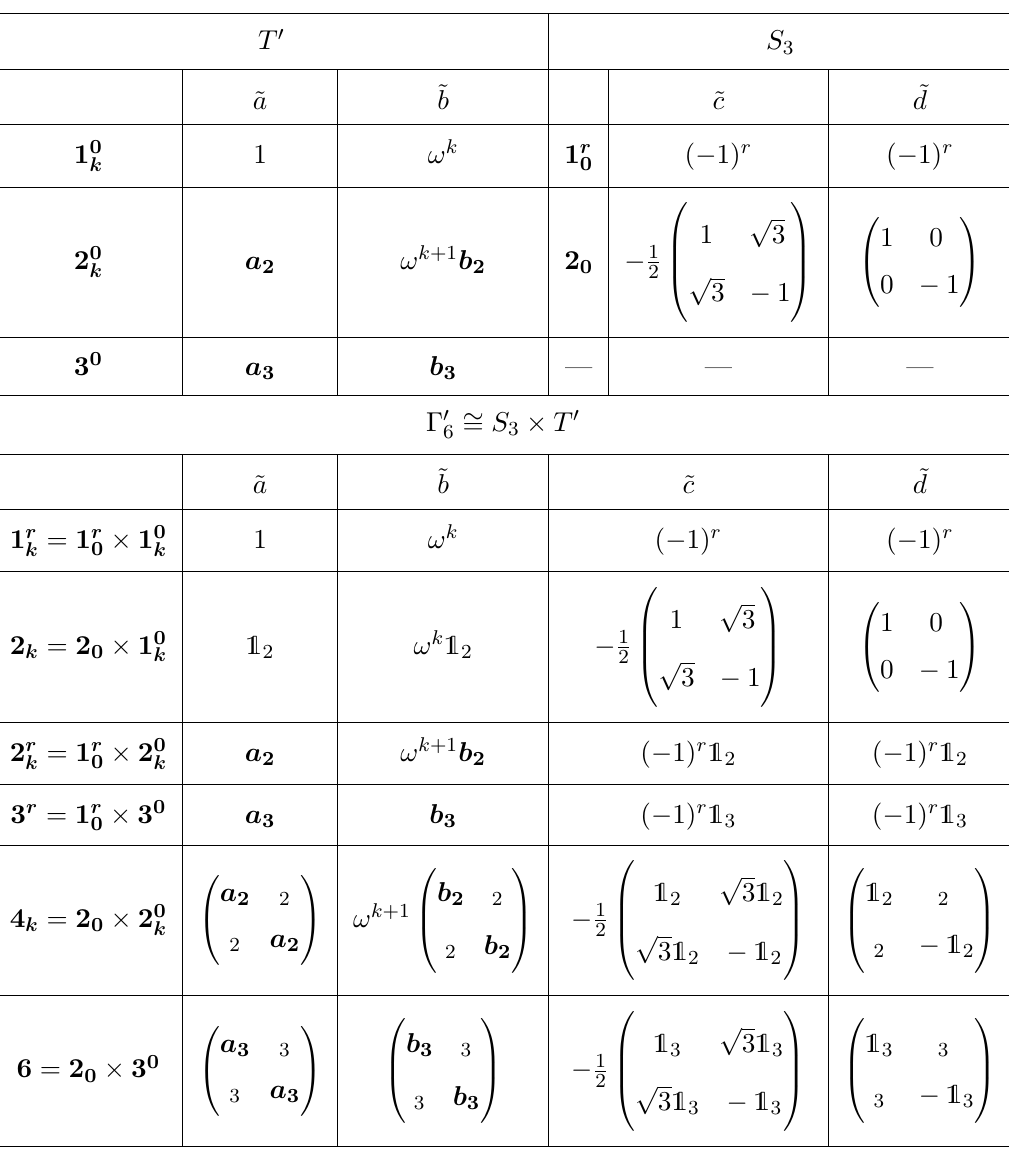
Table 6 . The representation matrices of the generators ˜ a , ˜ b , ˜ c and ˜ d for the irreducible representa- tions of groups T 0 , S 3 and Γ 0 in the chosen basis, where ω = e 2 πi/ 3 , r = 0 , 1 and k = 0 , 1 , 2 . In the 6 present work, the representation matrices of T 0 are related to those of [89] by the similarity trans- (cid:16) (cid:17) formation u 2 = diag 1 , e 5 πi 12 P 2 for two-dimensional representations 2 0 and u 3 = diag (1 , ω 2 , ω ) for k three-dimensional representation 3 0 . The representation matrices of generators of S 3 can be found in [4]. The irreducible representations of Γ 0 = S 3 × T 0 can be obtained from the direct products of 6 those of S 3 and T 0 [90]. For example, the two-dimensional representation 2 k of Γ 0 is exactly the 6 direct product 2 0 × 1 0 k